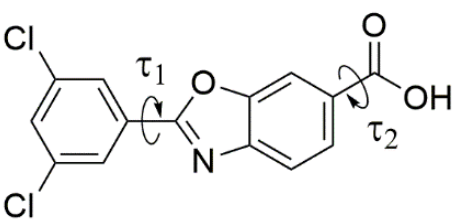
Figure 1. The molecular scheme and labeling of the freed torsion angles of the title compound.